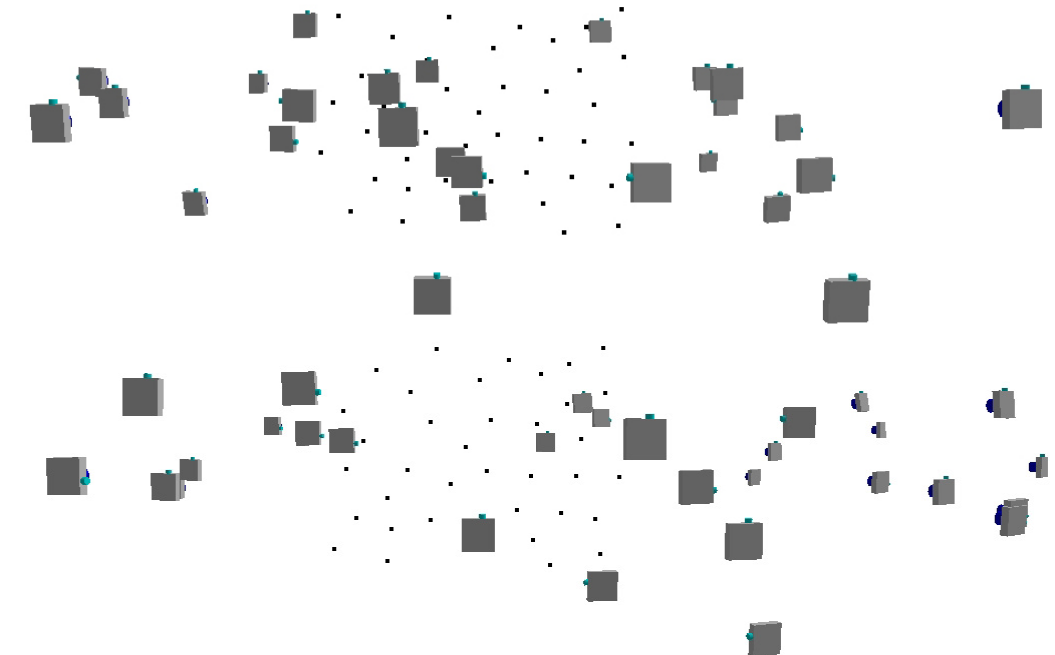
Figure 13. Recovered camera positions for two of the three amplitude image sets employed for the camera photogrammetric calibration.